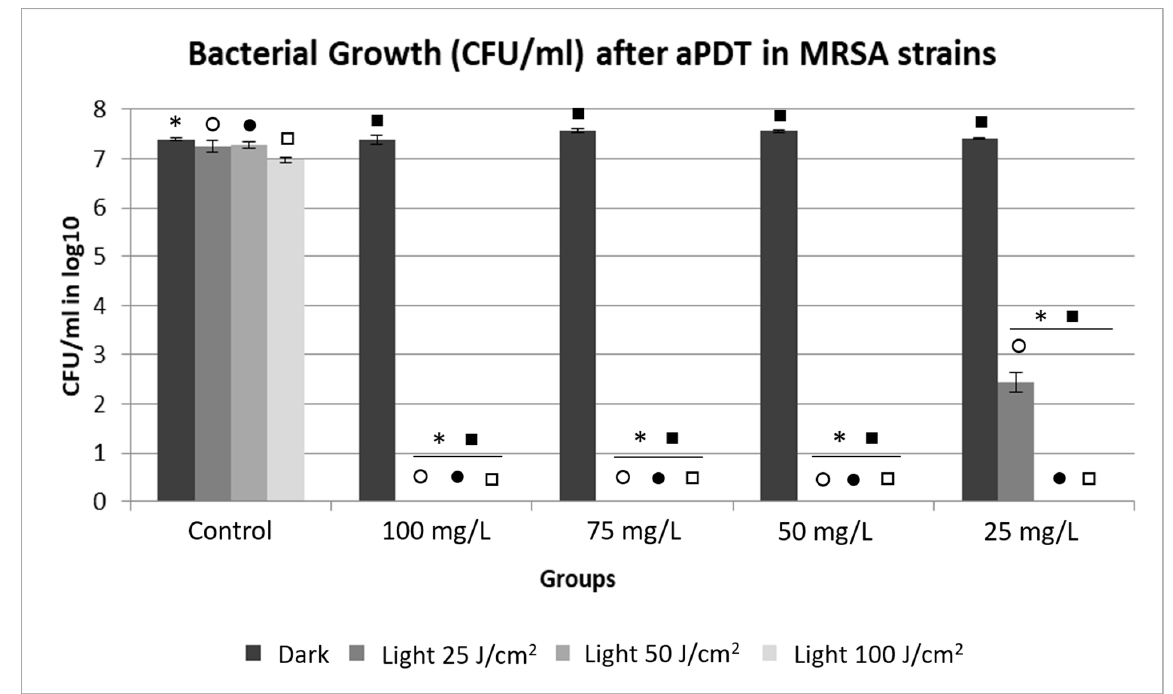
Figure 4. Average values of CFU/mL in log10 for MRSA strains showing Dark and Light control groups; Photodithazine ® at 25, 50, 75, and 100 mg/L; and non-irradiated and irradiated groups with fluences of 25, 50, and 100 J/cm 2 . * Significant differences were observed between the Dark Control group to 100, 75, 50, and 25 mg/L with Dark, light 25, 50, and 100 J/cm 2 groups. ○ Significant differences were observed between the light 25 J/cm 2 Control group to 100, 75, 50, and 25 mg/L with light 25 J/cm 2 groups. ● Signi fi cant di ff erences were observed between the light 50 J/cm 2 Control group to 100, 75, 50, and 25 mg/L with light 50 J/cm 2 groups. □ Signi fi cant di ff erences were observed between the light 100 J/cm 2 Control group to 100, 75, 50, and 25 mg/L with light 100 J/cm 2 groups. ■ Significant differences were observed between the Dark 100, 75, 50, 25 mg/L groups to 100, 75, 50, and 25 mg/L with light 100, 75, 50, and 25 J/cm 2 groups.